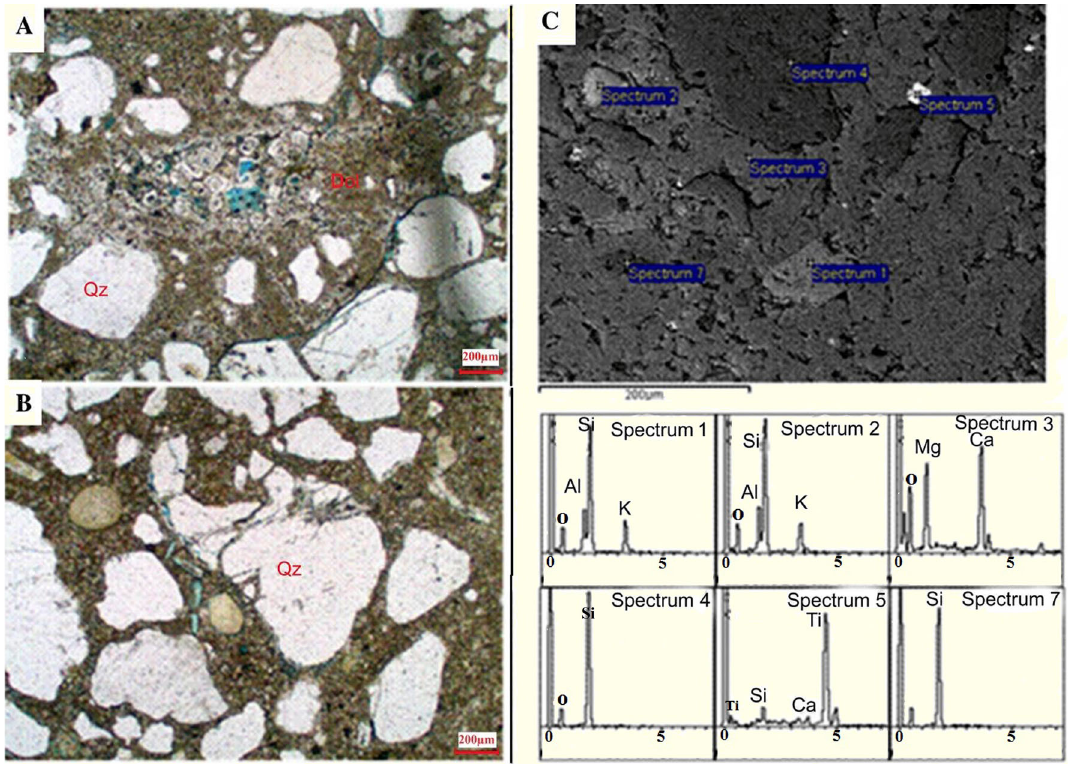
Fig. 6 a , b photomicrograph shows sandy dolomite: a sandstone with completely dedolomitized quartz grains. b Sandstone with partially dolomitized quartz grains. c SEM photomicrograph BSEI showing replacement of quartz grains by dolomite crystals as detected by